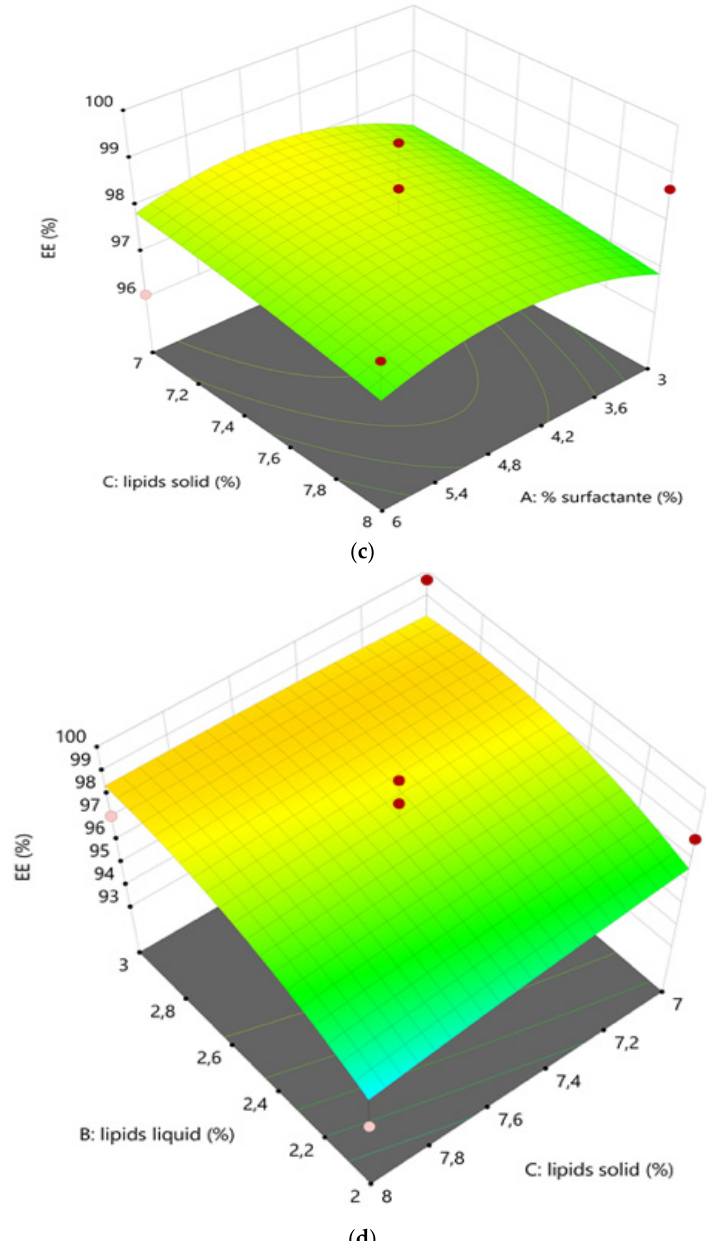
Figure 3. Pareto chart ( a ) and three-dimensional response surface plots showing the effect of the concentration of liquid lipid and surfactant ( b ), the concentration of surfactant and solid lipid ( c ) and the concentration of liquid lipid and solid lipid ( d ) on NLC ketoconazole encapsulation efficiency (EE), respectively.